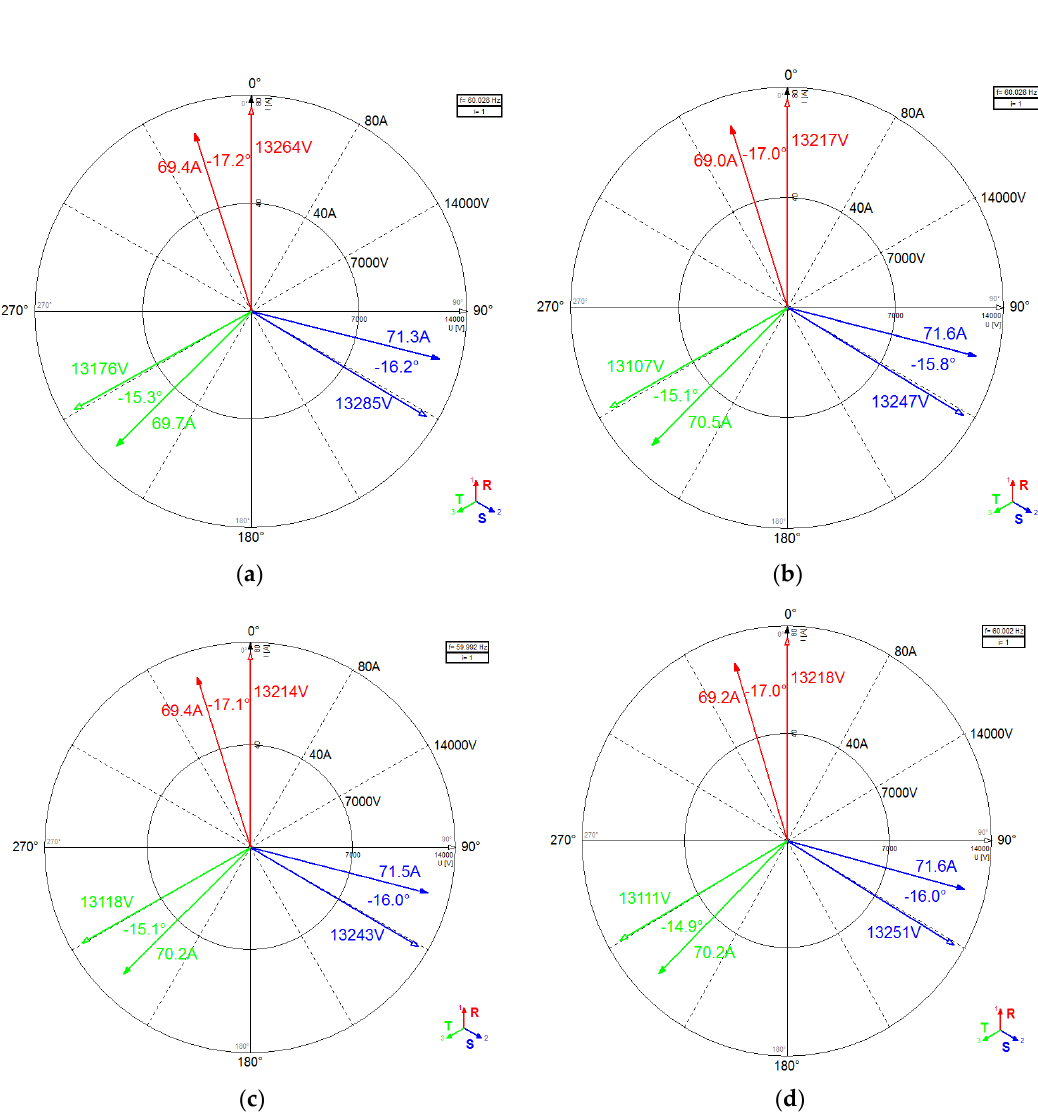
Figure 10. Non-reactor operations ( a ) first ( b ) second ( c ) third ( d ) fourth.